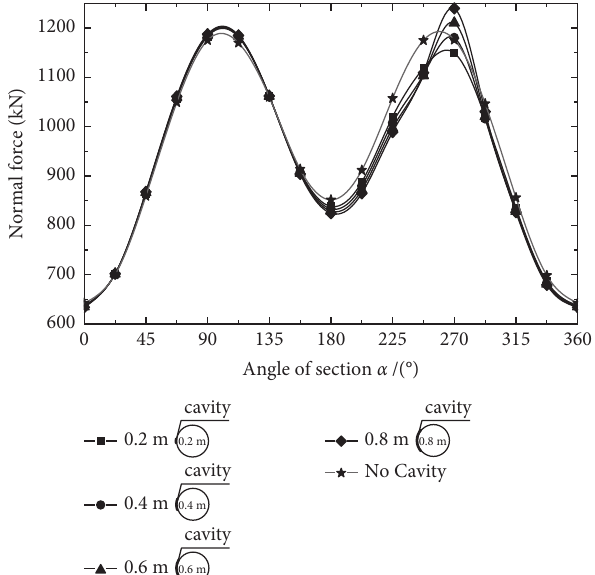
Figure 15: Distribution of axial force of the segment at different depths of the cavity behind the arch waist (unit: kN).